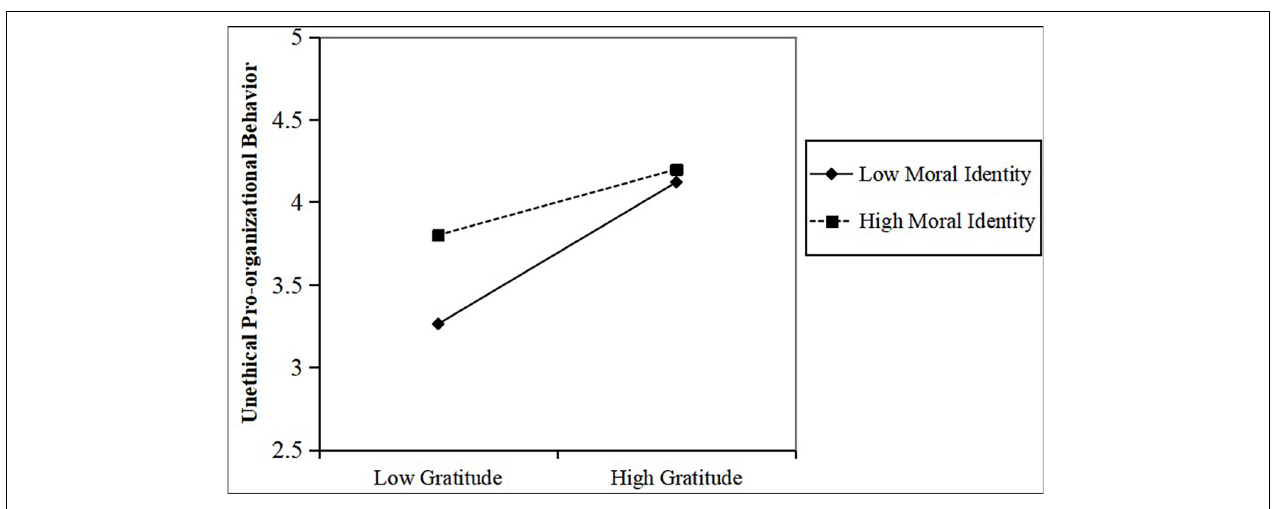
FIGURE 1 | The moderating effect of moral